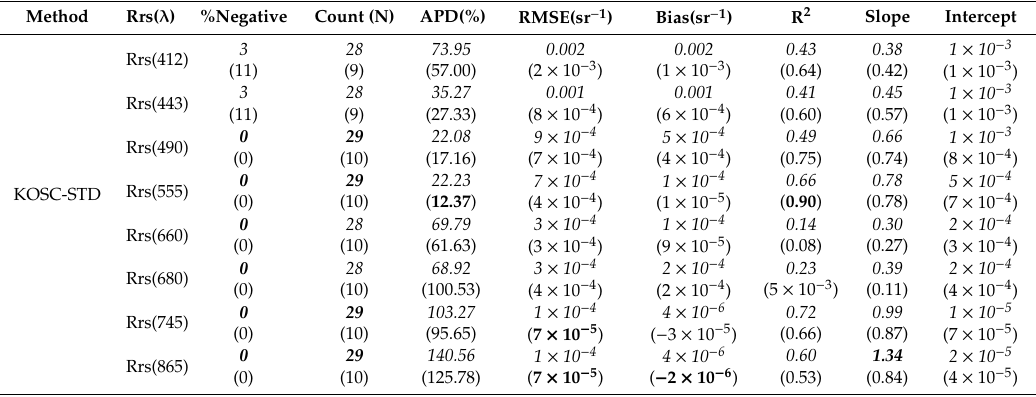
Table 2. Statistical results for GOCI-retrieved Rrs values obtained using the KOSC-STD algorithm and the in situ Rrs comparison at 02:16, 03:16, and 04:16 UTC for ± 3 h (values in parentheses indicate results for ± 1 h). The presentation style is the same as described in Table